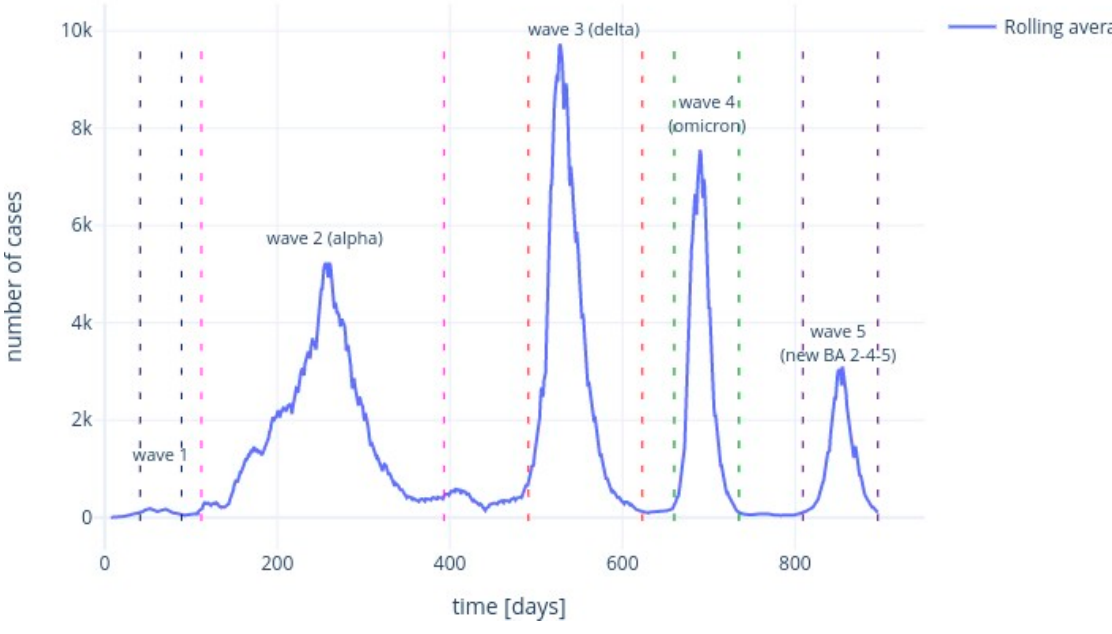
Figure 9. Morocco: COVID-19 five successive waves.